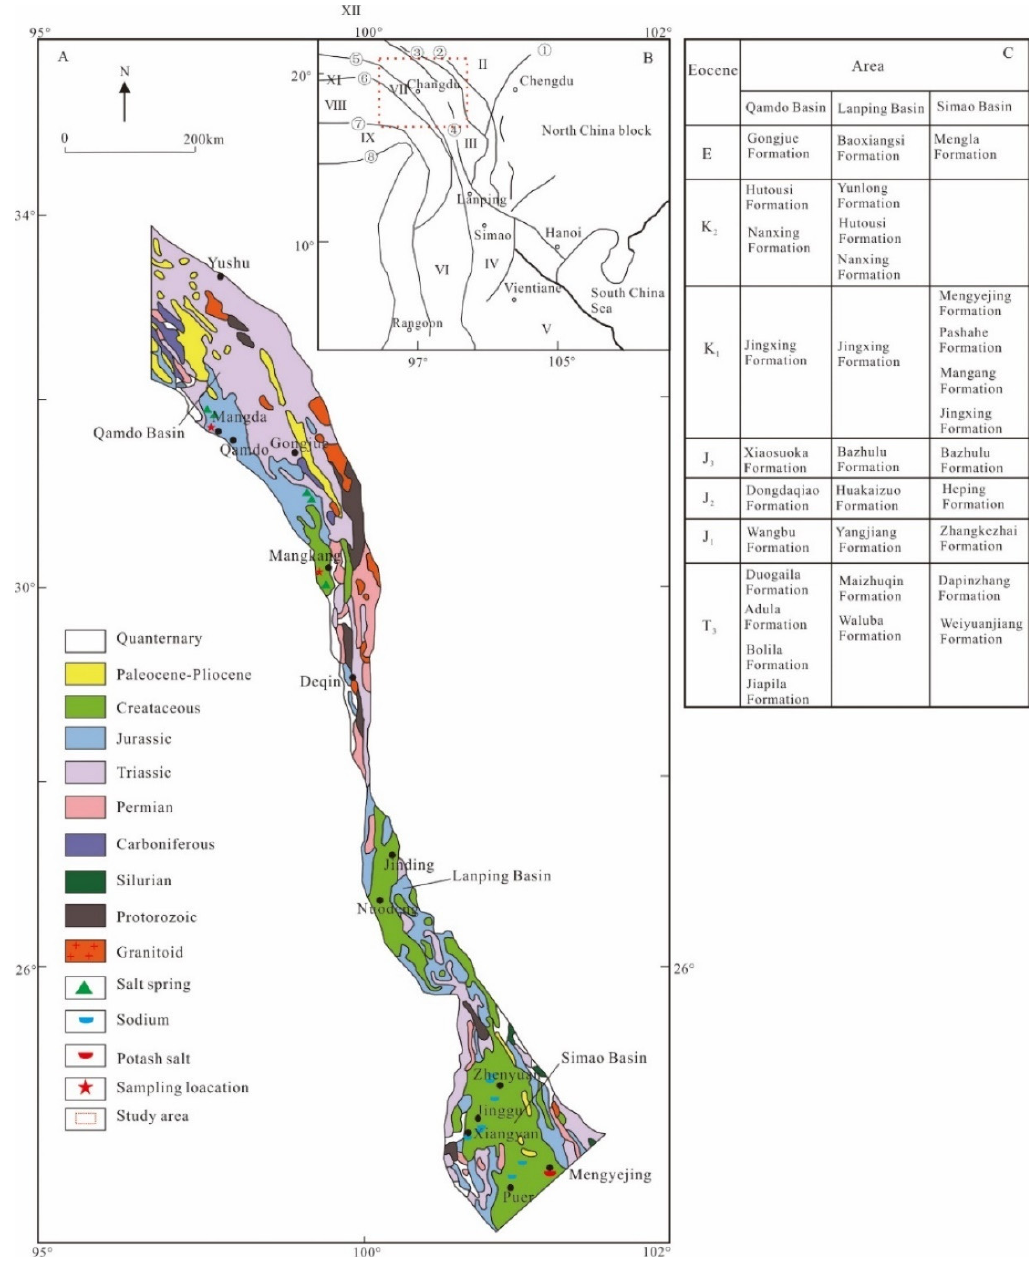
Figure 1. ( A ) geological map (modified after Song et al., 2011 [28]; salt springs after Qin et al., 2017 [29]; salts after Wang et al., 2018 [30]); ( B ) Schematic tectonic map of Qamdo: Notes: Ⅰ : North China Block; Ⅱ : Songpan-Ganzi Block; Ⅲ : Yidun Arc Terrane; Ⅳ : Qamdo-Simao Block; Ⅴ : Indochina Block; Ⅵ : Baoshan Block; Ⅶ : Qiangtang Block; Ⅷ : Gangdisi Arc; Ⅸ : Himalayan Block; Ⅹ : Himalayan Front Thrust Belt; Ⅺ : Qinghai–Tibet Plateau; ① Longmenshan Fault Zone; ② Daofu-Luhuo Fault Zone; ③ Garze-Litang Suture Zone; ④ Jinshajiang-Ailaoshan Suture Zone; ⑤ Shuanghu-Lancangjiang Suture Zone; ⑥ Bangong-Nujiang suture Zone; ⑦ Yarlung-Zangbo Suture Zone; ⑧ Himalayan Thrust Belt (modified after Hou et al., 1996 [31]); ( C ) Stratigraphic column (modified after Miao [32]).